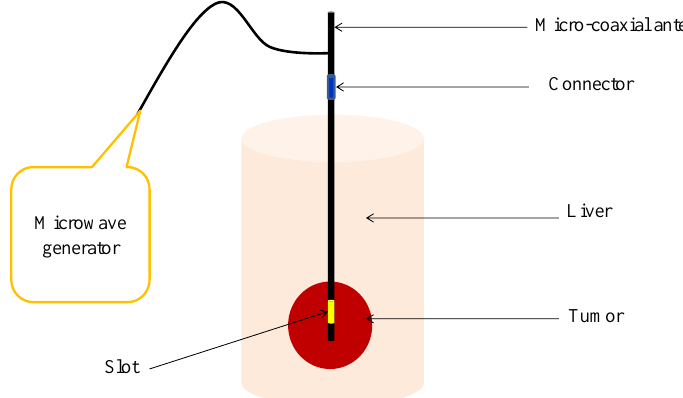
Figure 2. Schema of the antenna inserted into biological tissue.